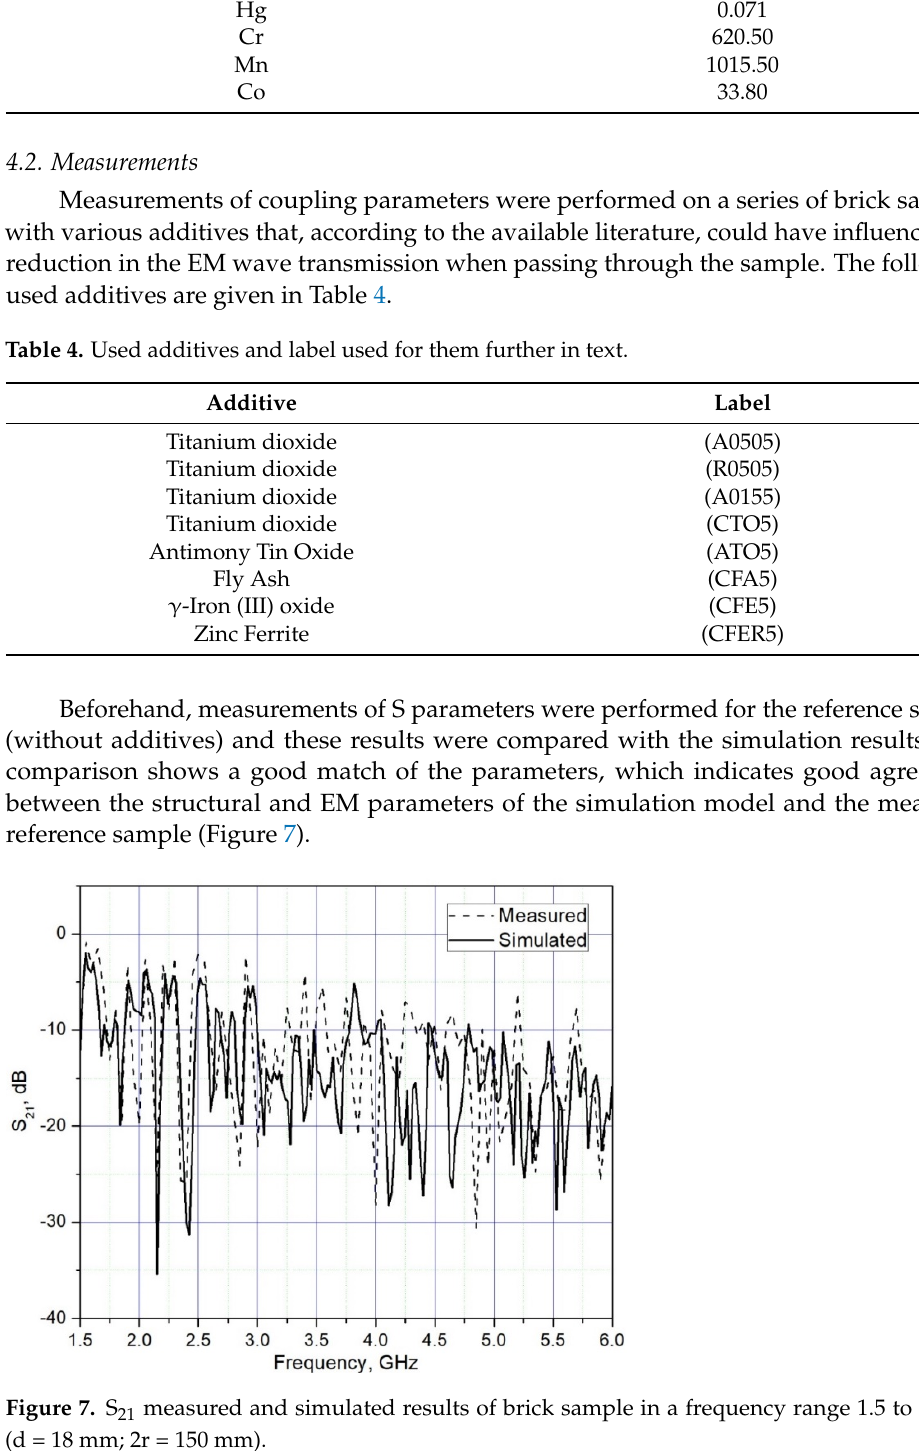
Figure 8. Measured S 21 parameter of brick samples in a frequency range 1.5 to 6 GHz, (d = 18 mm; 2r = 150 mm).